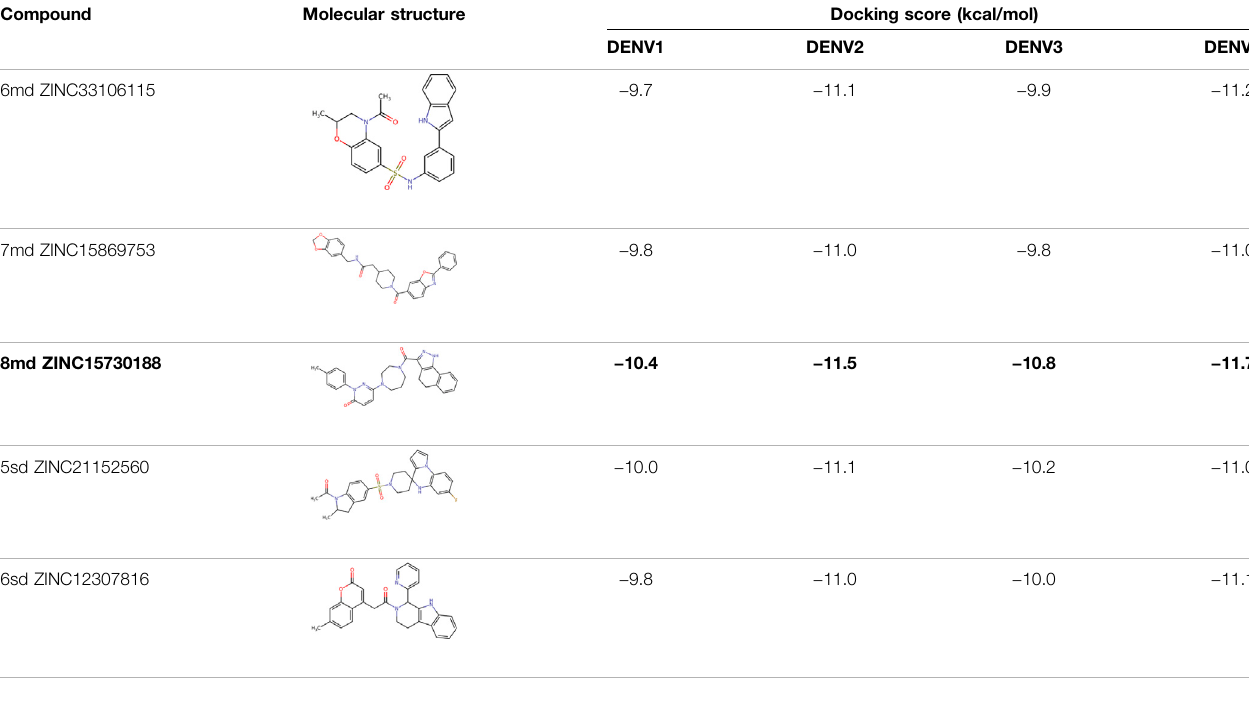
TABLE 3 | Best compounds obtained for the KDKE tetrad site of the four DENV serotypes. The best compound is highlighted in bold. Compound